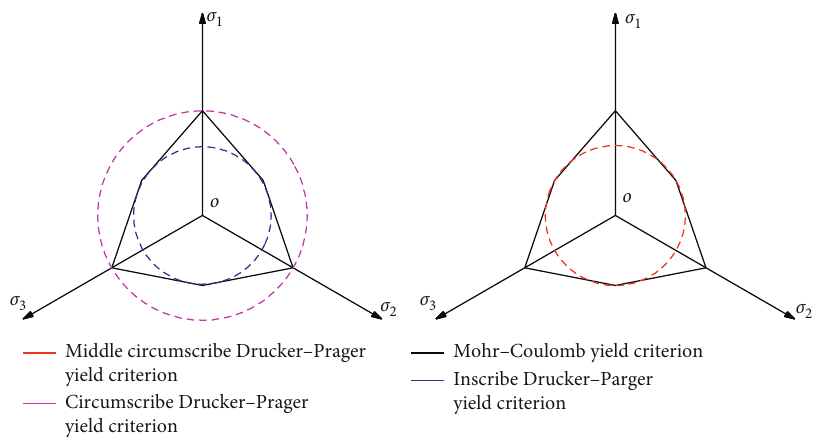
Figure 4: Drucker–Prager yield criterion curve in the π